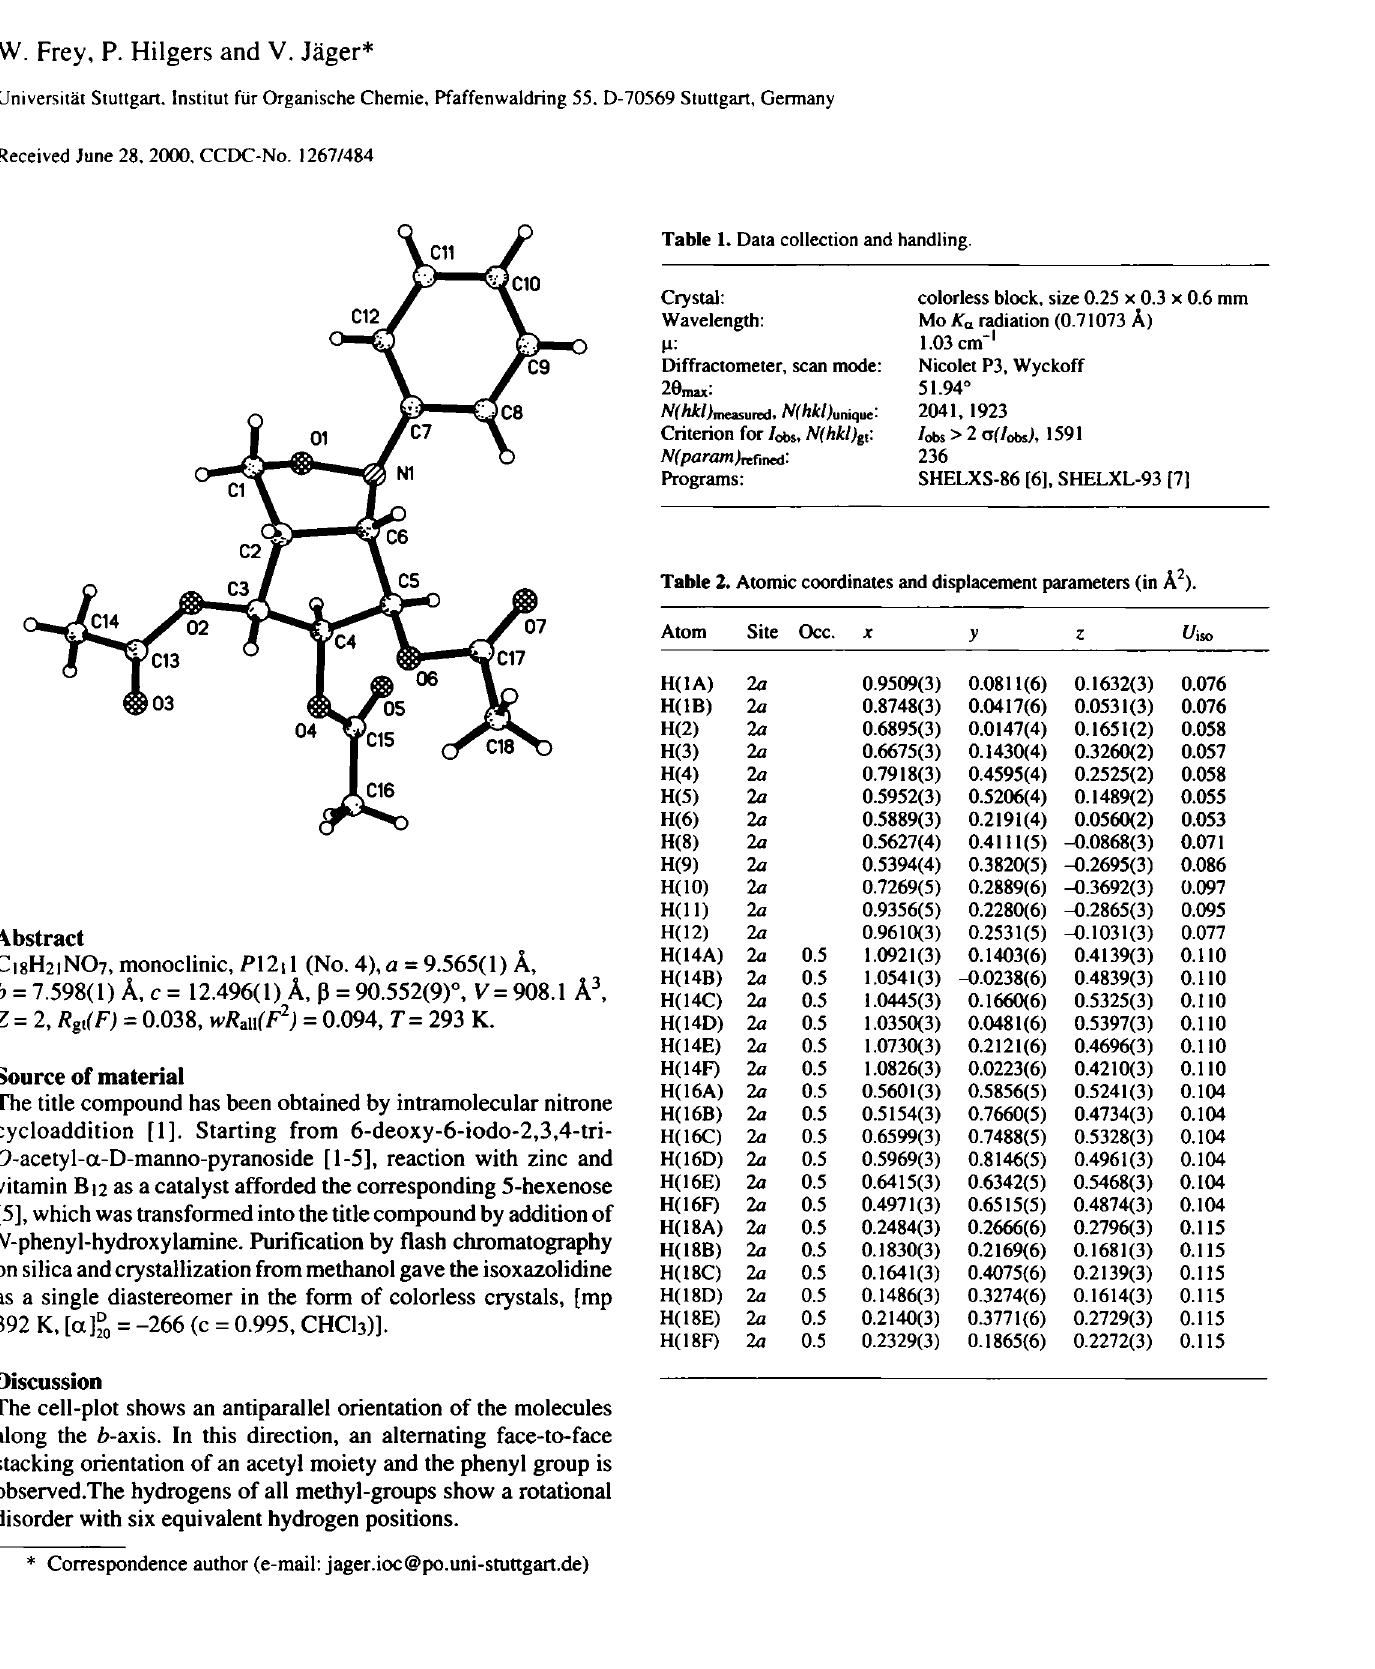
Table 1. Data collection and handling.